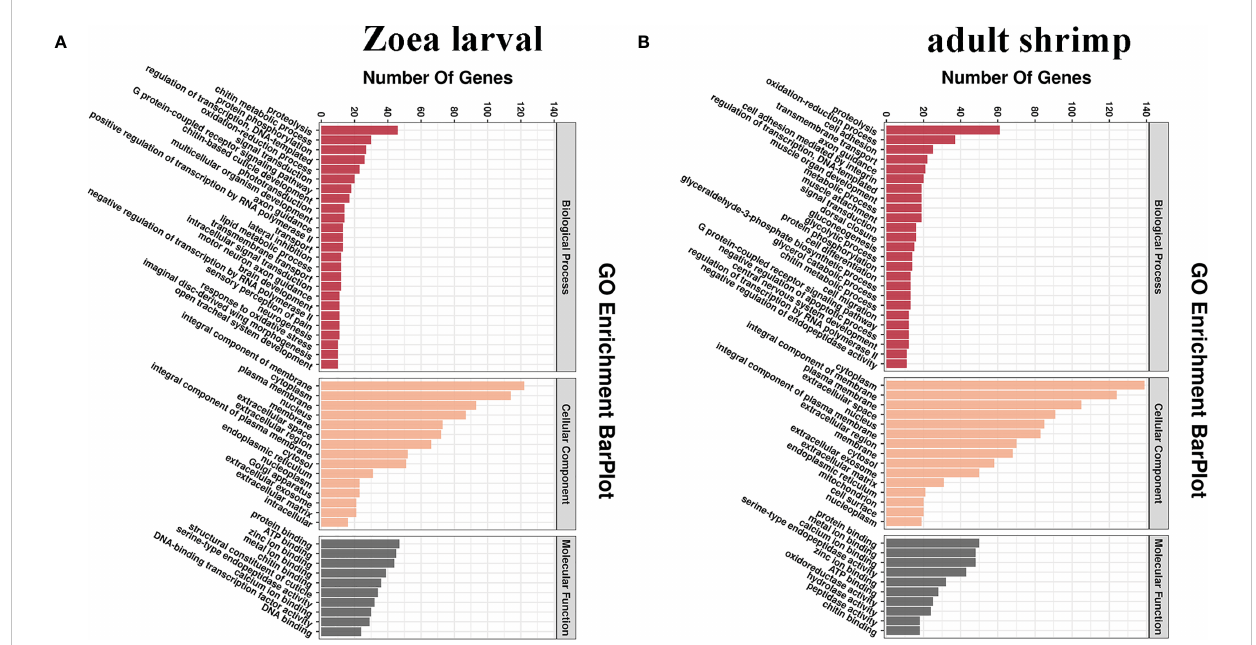
FIGURE 3 Gene ontology assignments for differentially expressed genes (DEGs) in Zoea larvae and adult after infection with V. parahaemolyticus . The GO classi fi cation results summarized in three main GO categories (cellular component, molecular function, and biological process). (A) GO analysis for the genes upon V. parahaemolyticus infected Zoea larvae. (B) GO analysis for the genes upon V. parahaemolyticus infected